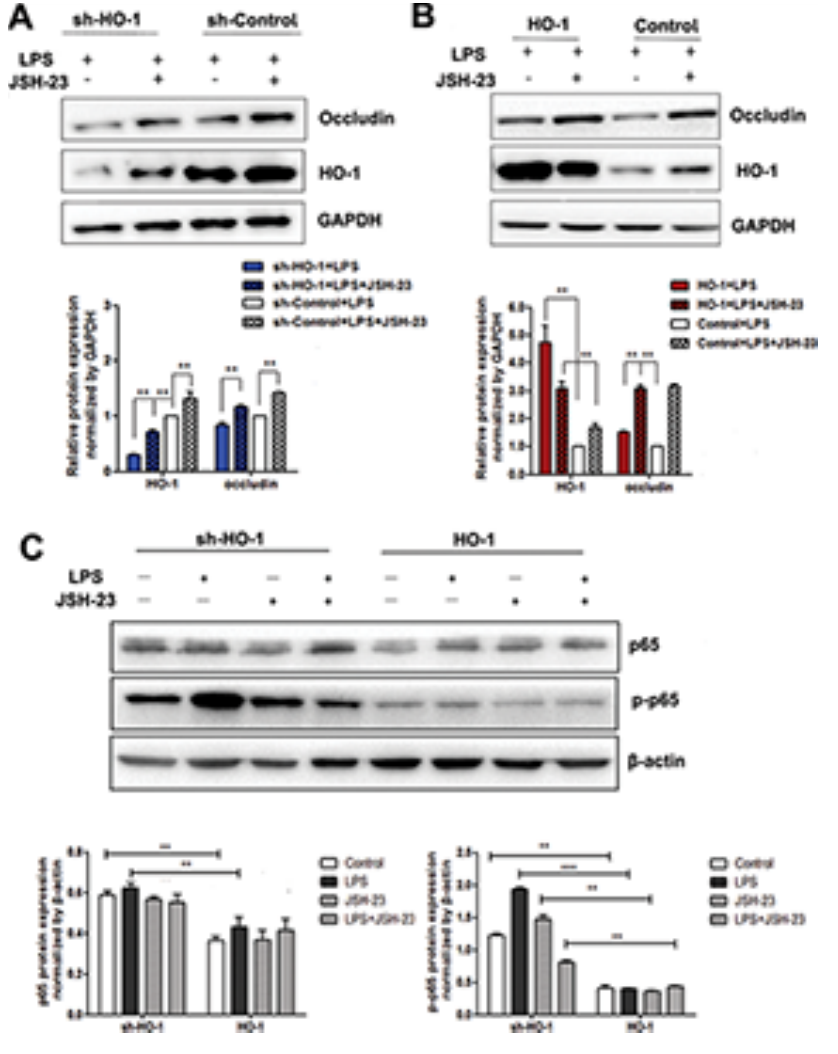
Figure 6. Effect of JSH-23 on occludin, p65 and p-p65 protein expression in Caco-2 cells in which HO-1 was overexpressed or knocked down. (A) HO-1 and occludin protein expres- sion in HO-1 knockdown (sh-HO-1) Caco-2 cells. (B) HO-1 and occludin in HO-1 overex- pressed Caco-2 cells. (C) p65 and p-p65 protein expression. The intensity of the band was quantified using the values obtained from the immunodetection of β -actin or GAPDH. Data are presented as the mean ± SD from three independent experiments, * P < 0.05, ** P < 0.01, *** P <